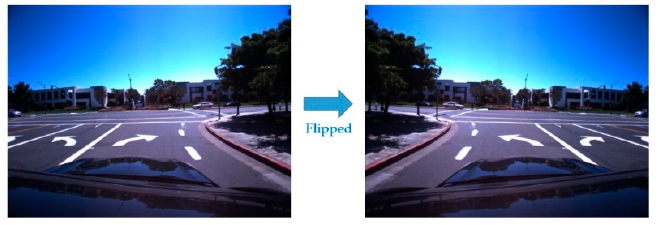
Figure 9. An example of data augmentation.